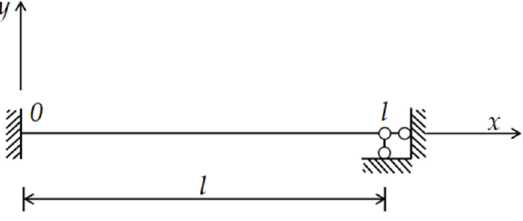
Figure 3. Cable with both ends fixed.